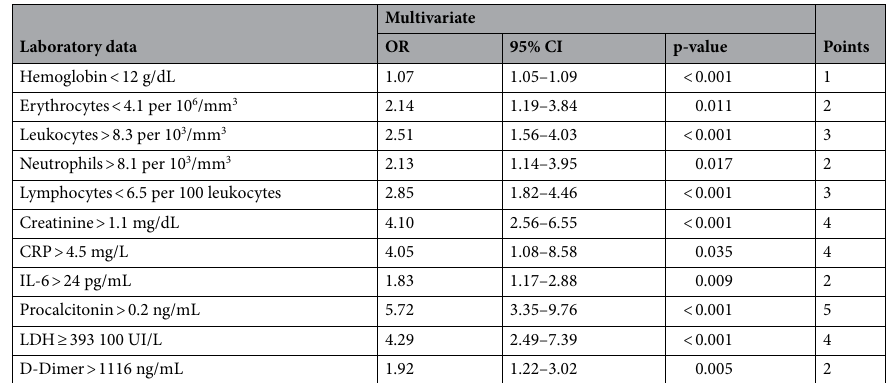
Table 4. Multivariate analysis for biomarkers to predict mortality basing on cut-off points (as categorial variables). Multivariate adjustment: age, comorbidities (hypertension, dyslipemia, diabetes mellitus, peripheral artery disease, heart disease, COPD/asthma), days of symptoms, respiratory insufficiency, in-hospital drugs (antiviral, chloroquine, ceftriaxone, corticosteroids, anticoagulation, antiplatelet).